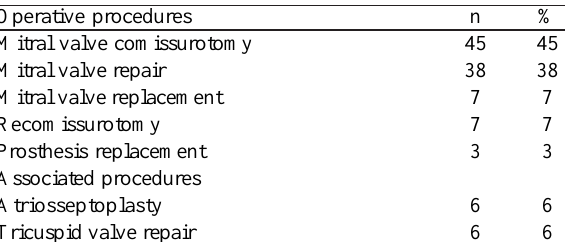
Table 1. Surgical